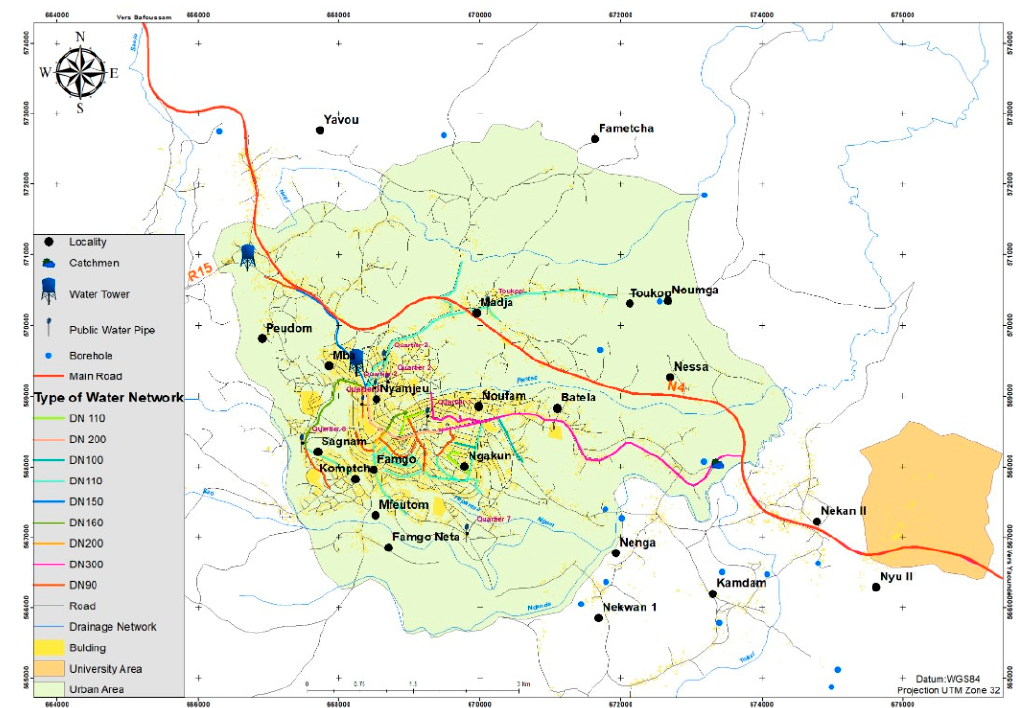
Figure 3. Hydraulic map of the city of Bangangté.